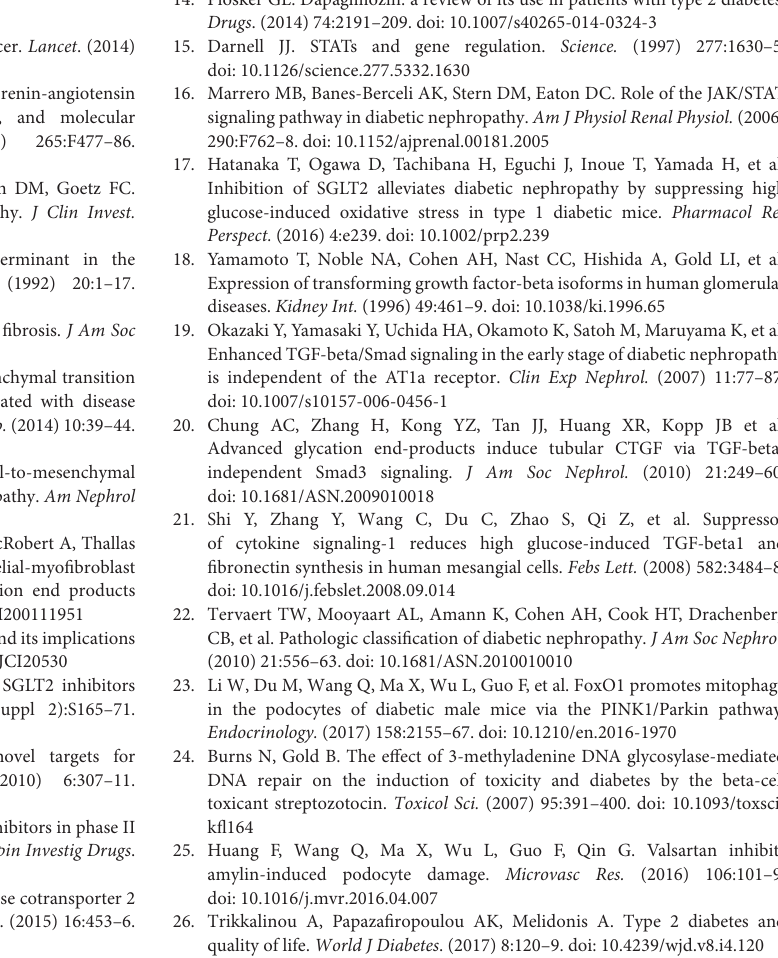
Supplementary Figure 1 | The western blots for STAT1, TGF β 1, FN and Col IV in all human kidney samples. Supplementary Figure 2 | The mRNA expressions levels of STAT1, E-cadhein and a-SMA in HK-2 cells treated with TGF- β 1 and high glucose. ∗ P < 0.05 vs.